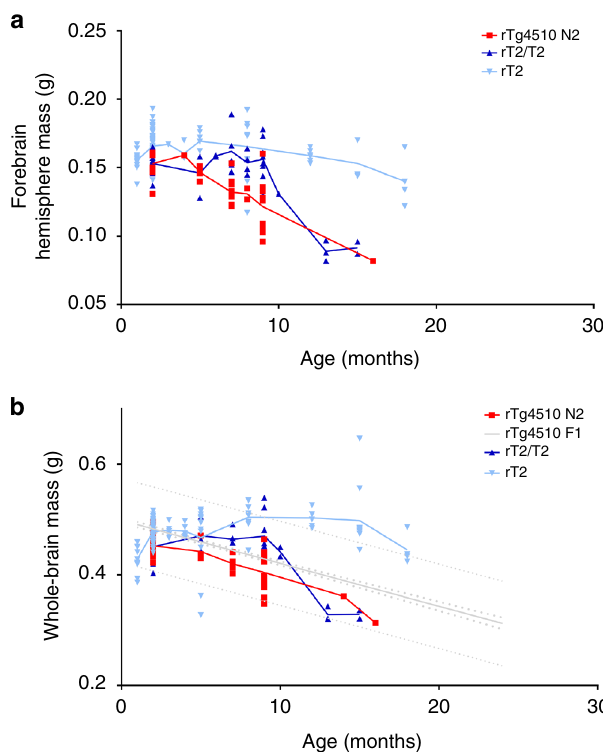
Fig. 2 Pilot experiments with aged rT2 and rT2/T2. Forebrain-hemisphere a and whole brain b mass were measured for rT2/T2 ( n = 32), rT2 ( n = 120), rTg4510 F1 (FVB/129S6) ( n = 554, accumulated data from Ashe lab), and rTg4510 N2 (FVB× FVB/129S6) ( n = 32). Tissue samples were collected at varying ages, with limited numbers at the oldest ages (>12 months). Note that the genetic background of rTg4510 N2 is matched to rT2/T2 and that of rTg4510 F1 is matched to rT2. A comparison between rT2 and rT2/T2 reveals that severe loss in forebrain mass similar to rTg4510 is only observed in mice >12 months and only at the higher levels of transgene overexpression. Lines represent connected means. Thick dotted lines for rTg4510 F1 data represent 95% con fi dence bands while thin dotted lines represent 95% prediction bands. Source data are provided as